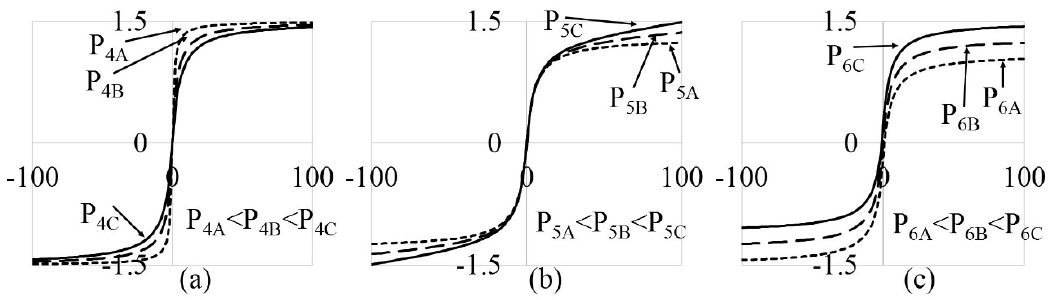
Figure 7. Meaning of parameters: ( a ) P 4 ; ( b ) P 5 ; ( c ) P 6 used in the Elliot expression.